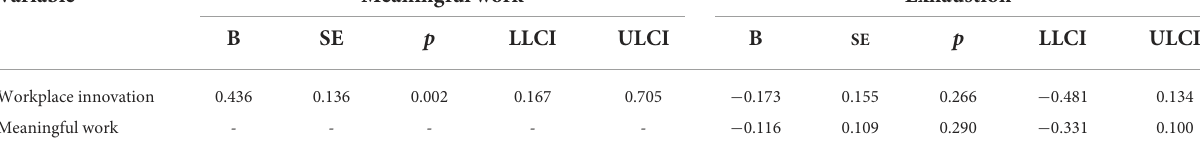
TABLE 2B Mediation results for